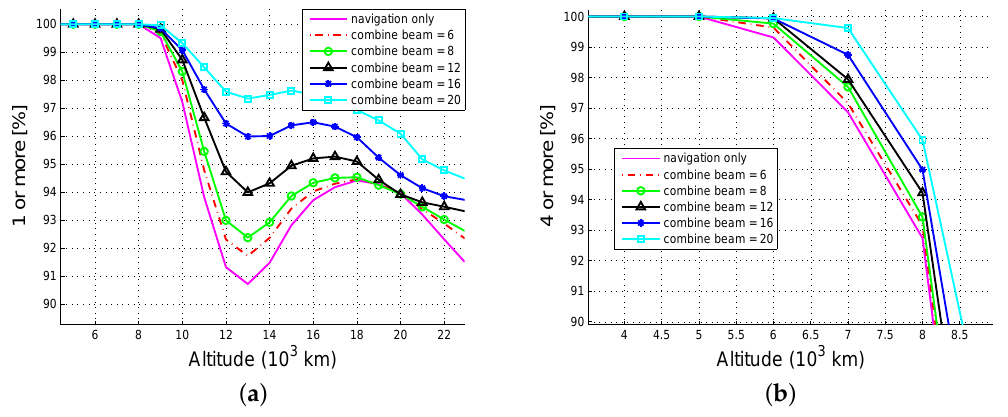
Figure 15. The combined availability of ISL and navigation signal: ( a ) one or more; ( b ) four or